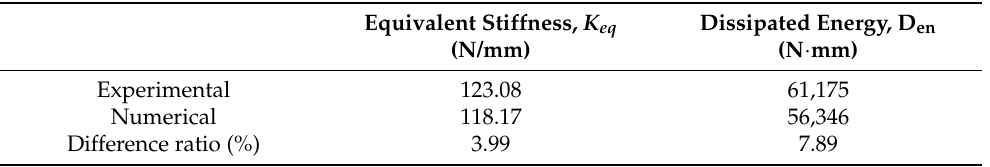
Figure 7. Comparison of shear behaviours of the two similar bridge bearings under cyclic loading at a 25% shear strain between numerical and experimental data. Table 2. Showing a comparison of the equivalent horizontal stiffness ( K eq ) and the dissipated energy (D en ) of the proposed model at a 25% shear stain between the experimental and numerical results.